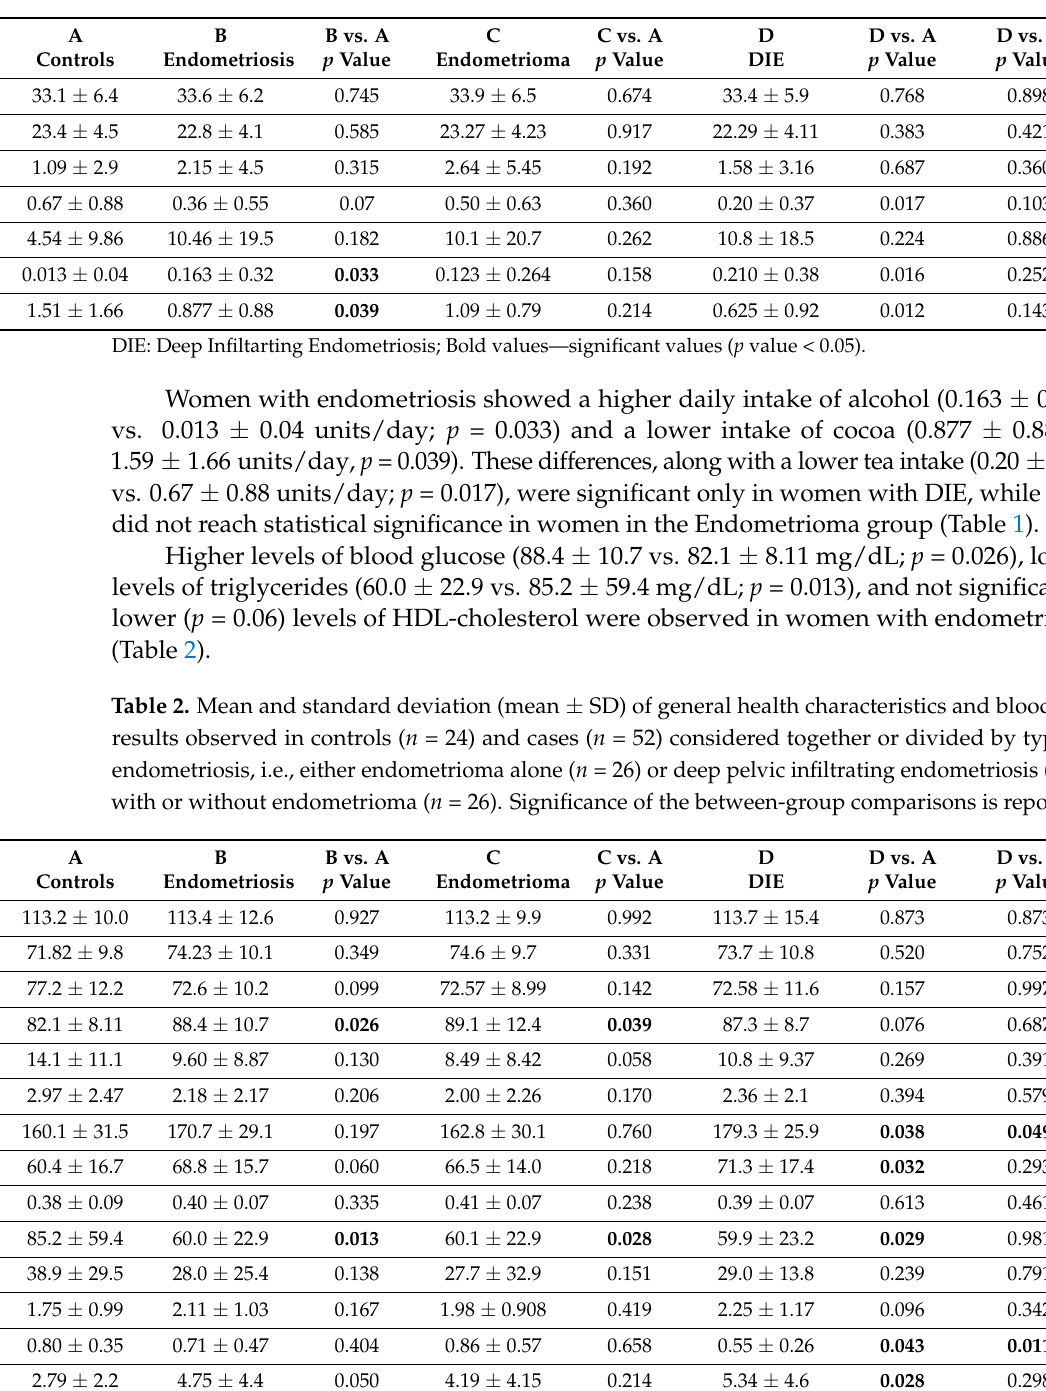
Table 1. Mean and standard deviation (mean ± SD) of general and lifestyle characteristics observed in controls ( n = 24) and cases ( n = 52) considered together and divided by type of endometriosis, i.e., either endometrioma alone ( n = 26) or deep pelvic infiltrating endometriosis (DIE) with or without endometrioma ( n = 26). Significance of the between-group comparisons is reported.